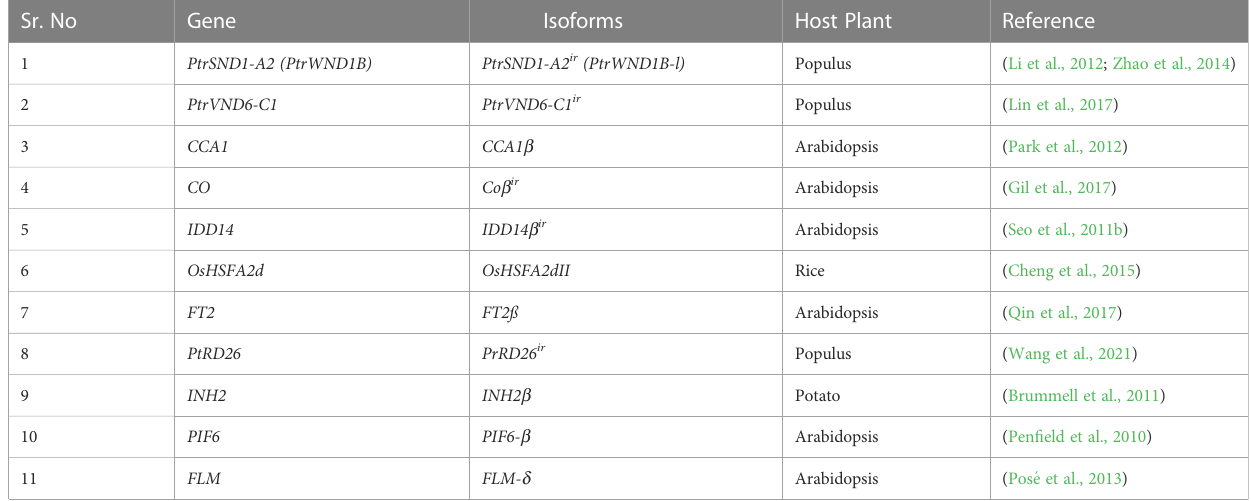
TABLE 1 List of introns retaining transcripts involved in transcriptional suppression. Sr. No